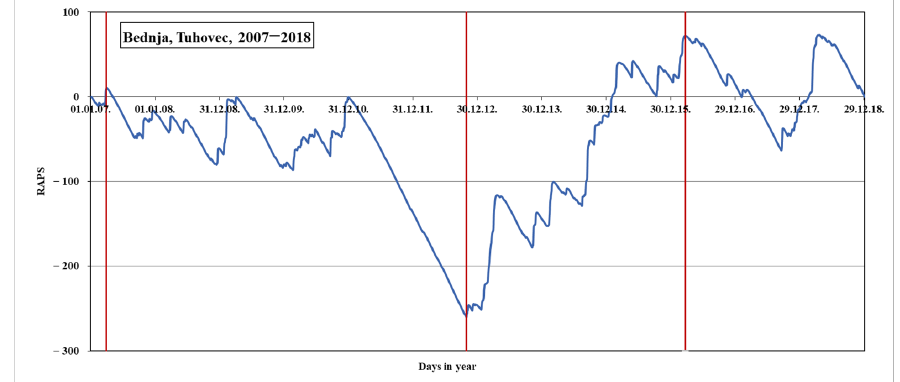
Figure 15. RAPS value on flow data from Tuhovec measurement station.